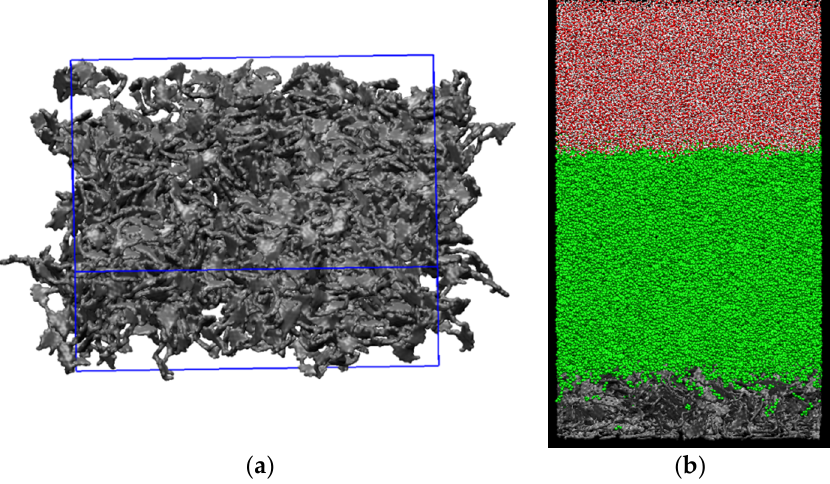
Figure 2. A snapshot of ( a ) rough kerogen surface and ( b ) simulation box containing the solid kerogen surface at the bottom, oil phase in the middle, and water phase on top. The kerogen surface is 1 nm thick.